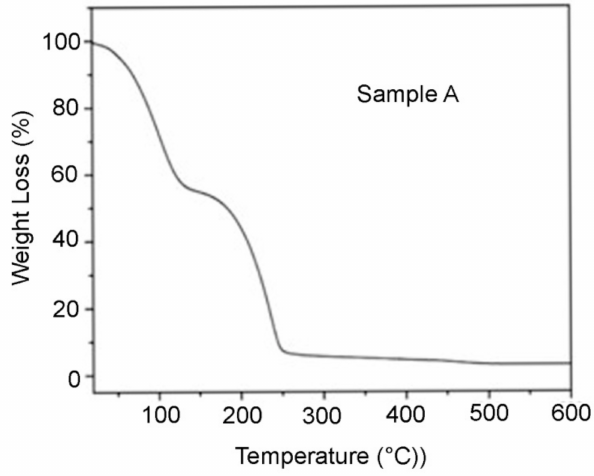
Figure 4. Thermogravimetric analysis (TGA) of hydrogel from sample 3-3 (Sample A) within a temperature range of about 23 ◦ C to about 600 ◦